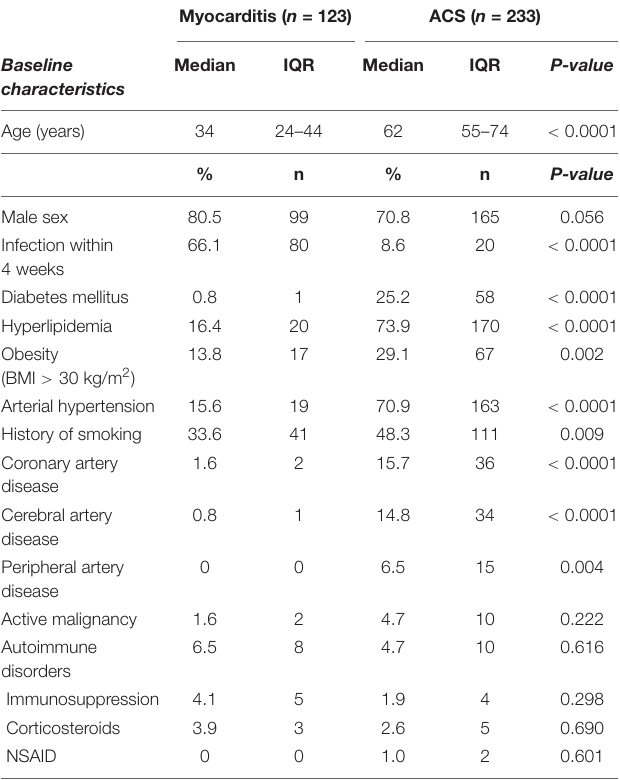
TABLE 1 | Baseline characteristics of both groups.